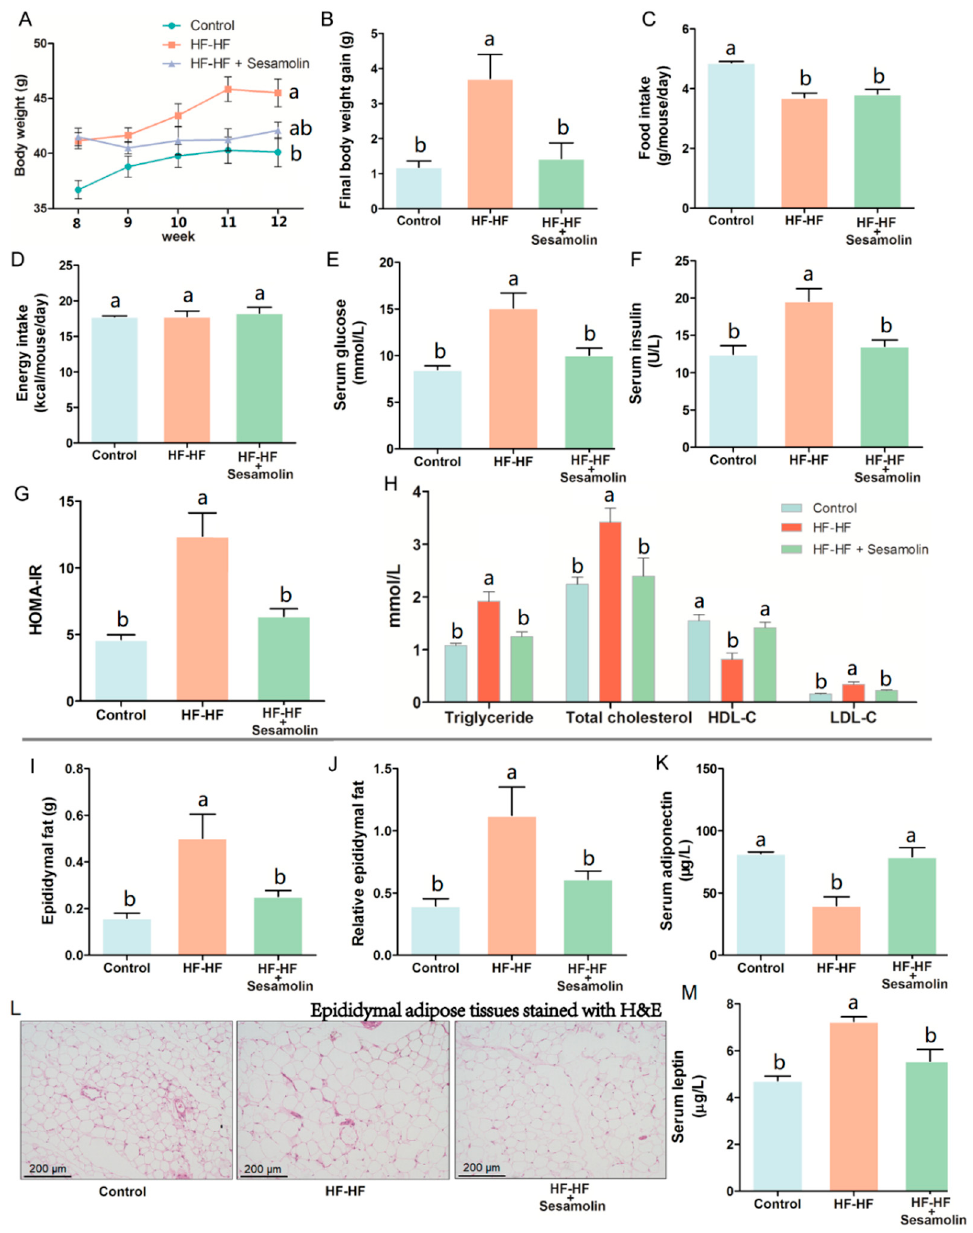
Figure 1. Sesamolin suppresses obesity and metabolic disorders in HF-HF diet-fed mice. ( A ) Changes in average body weight from week 9 to week 12. ( B ) Final body weight gain. ( C ) Average amount of food intake. ( D ) Average energy intake. Serum levels of ( E ) glucose, ( F ) insulin, and ( G ) HOMA-IR. ( H ) Serum levels of triglyceride, total cholesterol, HDL-C, and LDL-C. ( I ) Epididymal fat weight. ( J ) Relative epididymal fat weight. ( K ) Serum levels of adiponectin. ( L ) Epididymal adipose tissues stained with H&E. ( M ) Serum levels of leptin. Results are presented as mean ± SEM ( n = 8). Different letters express significant differences, p < 0.05.